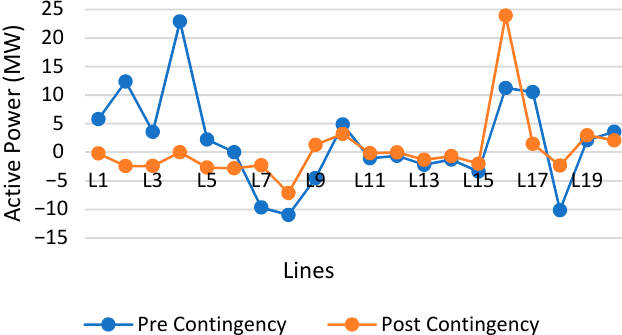
Figure 7. Pre- and post-contingency active power flow from each line.